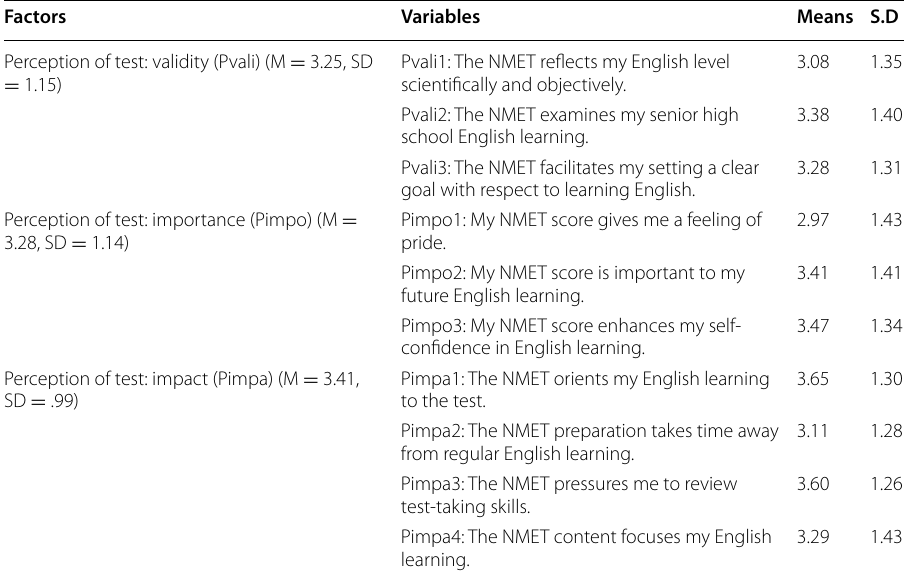
Table 1 Descriptive statistics results of test perceptions Factors Variables Means